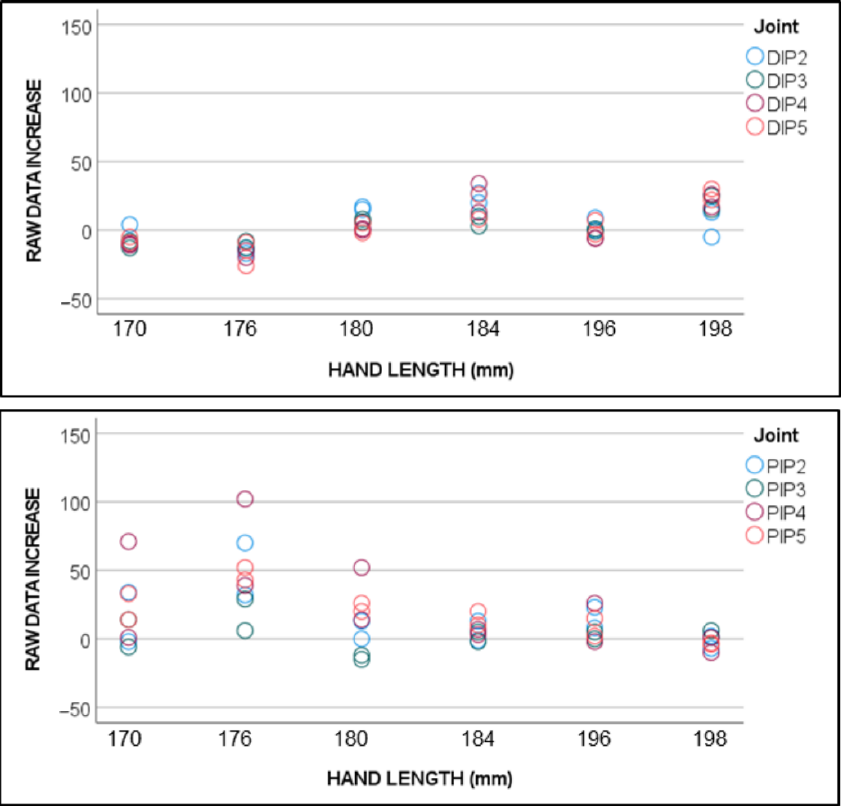
Figure 4. A participant performing the Sollerman Hand Function Test while wearing the 22 DoF CyberGlove.